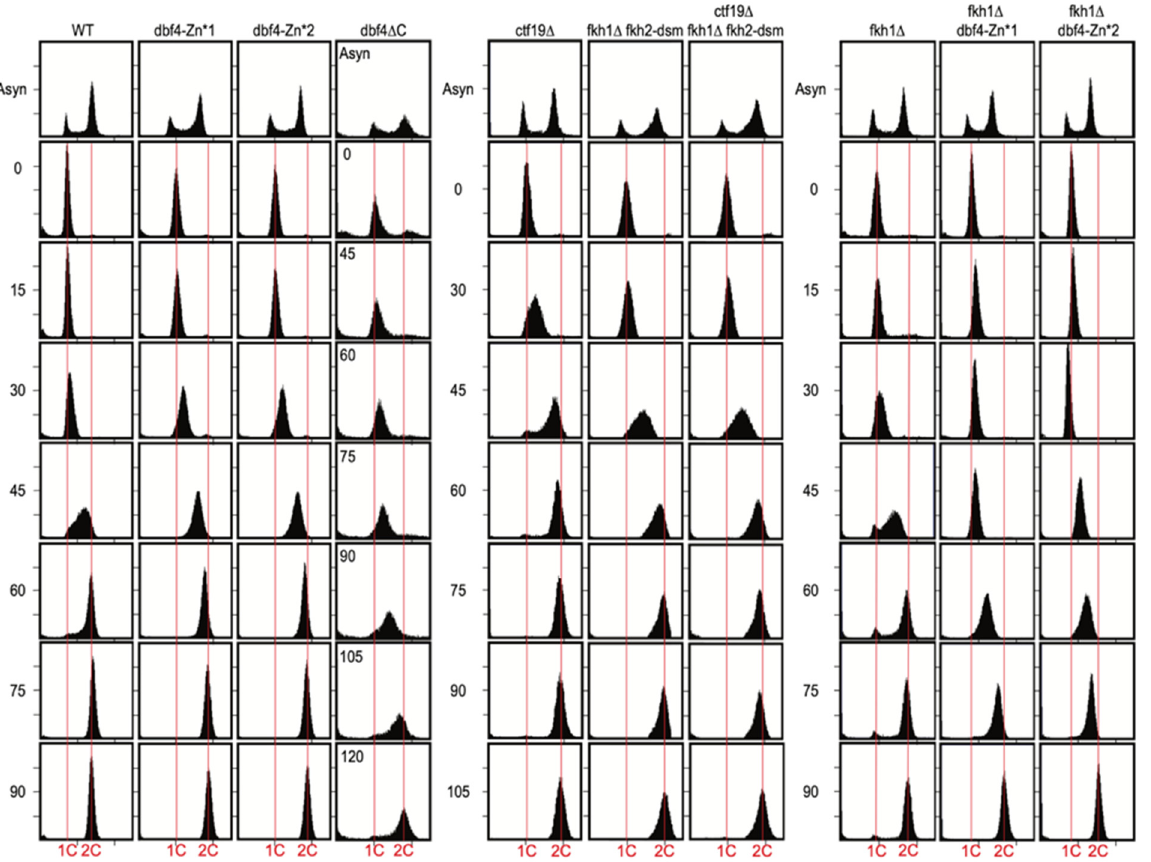
Figure 2. Dbf4 ∆ C is defective in bulk genome replication, while Dbf4-Zn* mutants are not. Strains described in Figure legend 1 plus HYy217 ( fkh1 ∆ ) and HYy215 ( dbf4 ∆ C —instead of HYy176) were synchronized in G1 phase and released into S phase for DNA content analysis. Note the different time intervals of the different panels, and the unique time intervals for dbf4 ∆ C (inset). Vertical red lines indicate 1C (un-replicated) and 2C (replicated) chromosomal DNA contents, respectively.